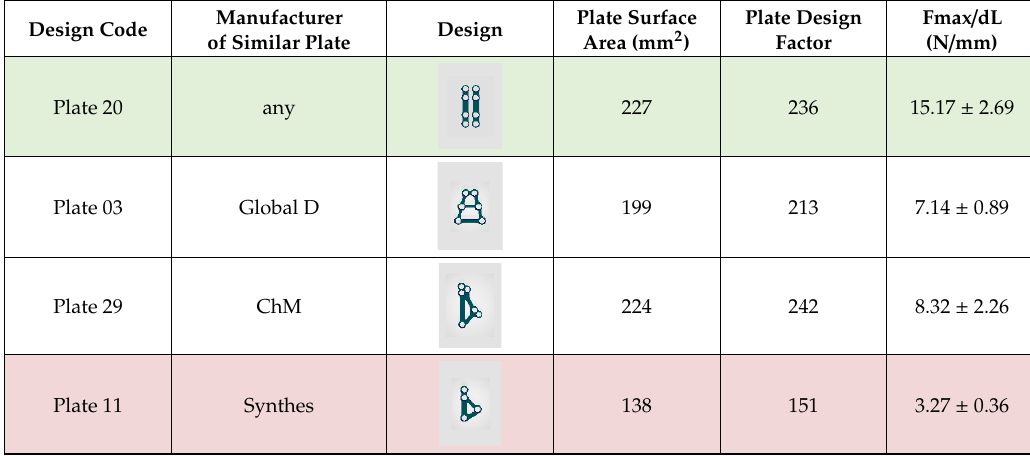
Table 1. Tested designs of plates dedicated for osteosynthesis of basal condylar fractures of the mandible. Green cells indicate the best mechanical designs (the highest force is required for 1-millimeter displacement in fracture line after osteosynthesis, F max/dL). Red cells indicate the worst mechanical designs (the lowest force required for 1-millimeter displacement in fracture line after osteosynthesis).